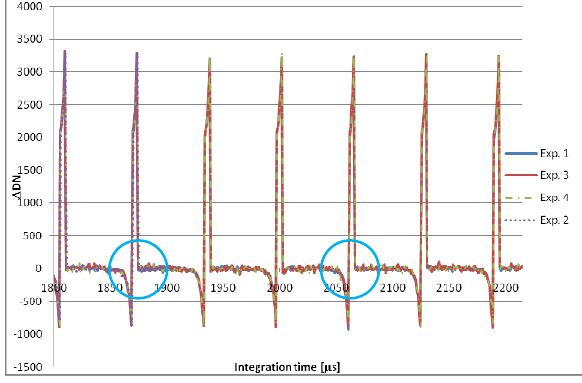
Figure 6. Errors in DN values ( ∆ DN) obtained during four experiments at four different scene illuminations. Figure 4. Experiment set-up Further calculations has shown, that independent from the scene illumination, the errors in DN values occurring at specific integration times are always constant in their values. The table below shows the ∆ DN values, calculated as the difference between the measured and theoretical DN values, for two chosen integration time ranges (marked with a circle in Figure 6).